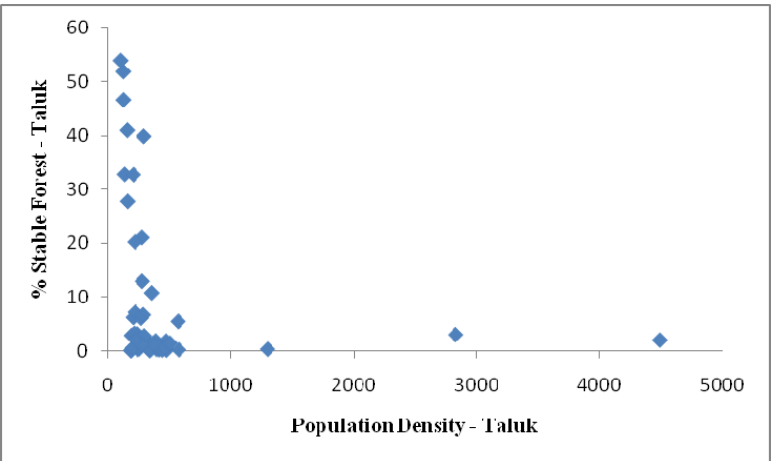
Figure 5b. Relationship between population density and the distribution of stable forest for